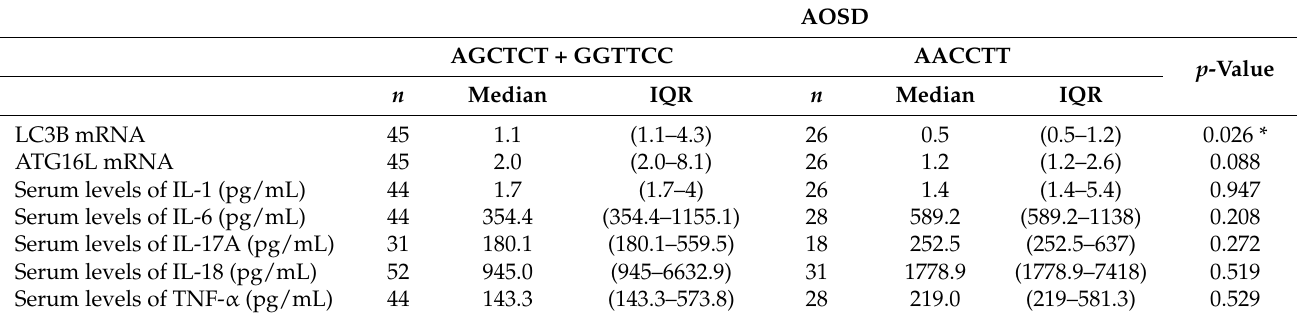
Table 3. A comparison of serum levels of LC3B mRNA, ATG16L mRNA, and inflammatory cytokines between different haplotypes in AOSD